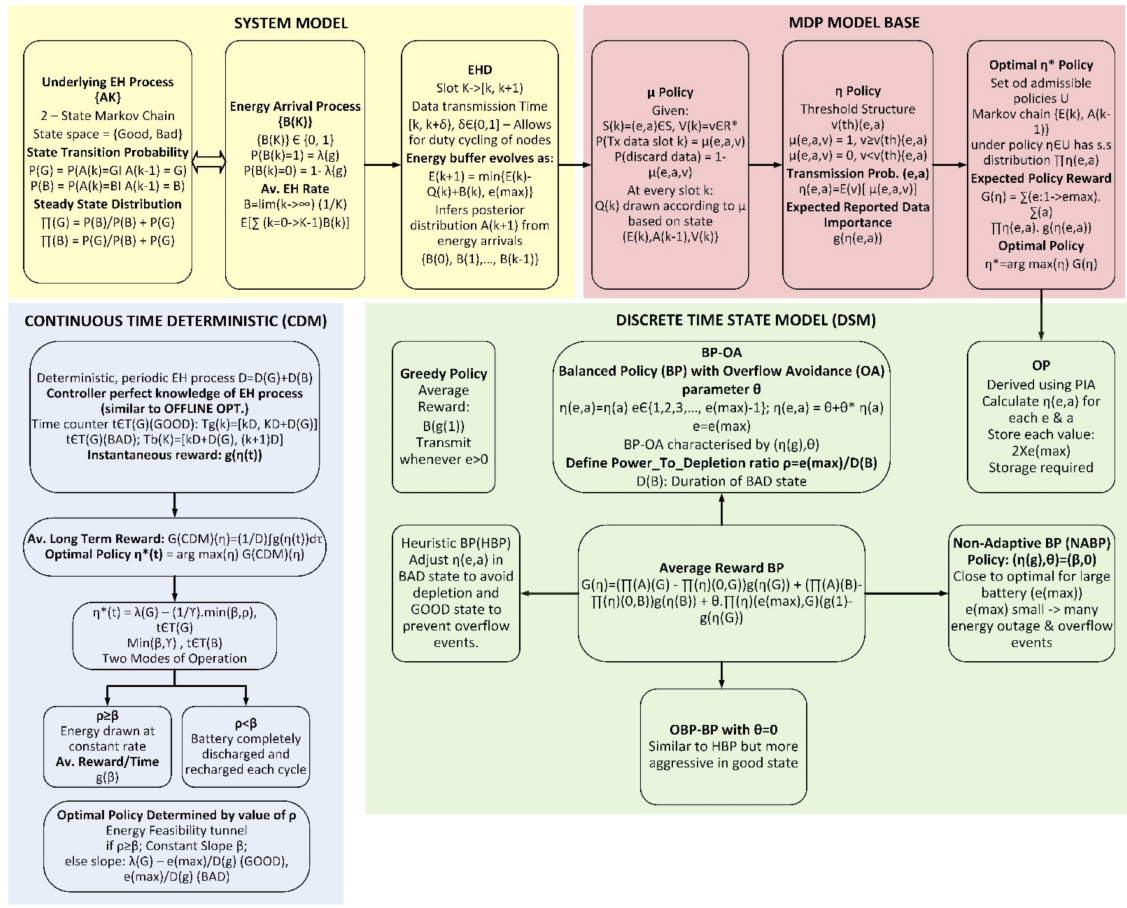
Figure 7. System models for online transmission policies with correlated energy